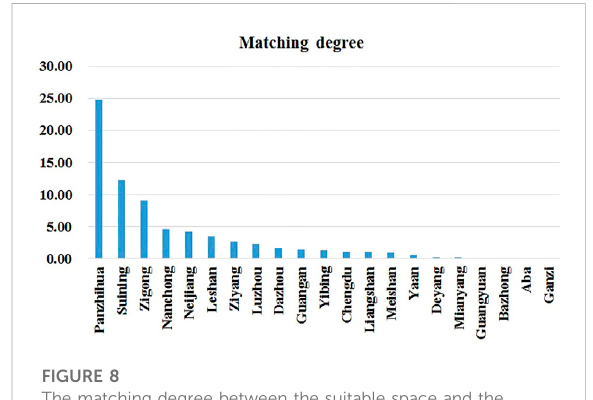
FIGURE 8 The matching degree between the suitable space and the production space of citrus in